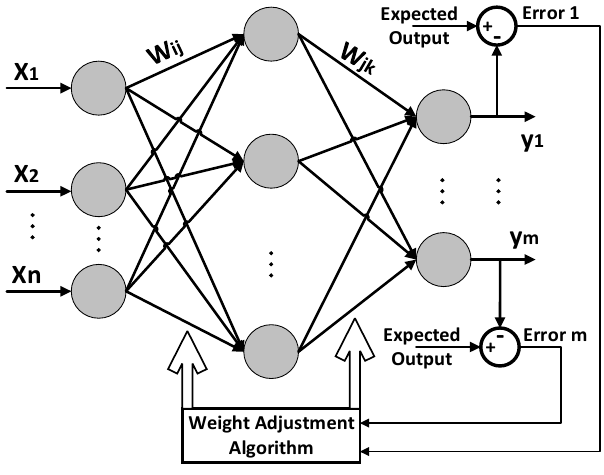
Figure 12. Topology structure of ANN model.